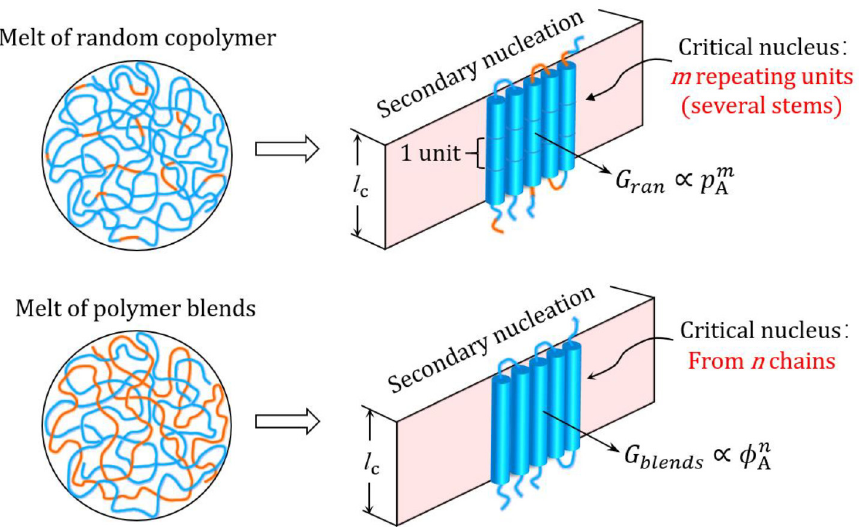
Figure 5. Scheme for determining the size of a critical secondary nucleus based on the crystalliza- tion kinetics of random copolymer and miscible crystallizable/amorphous polymer blends. Adapted with permission from Reference [62]. Copyright 2019, American Chemical Society.